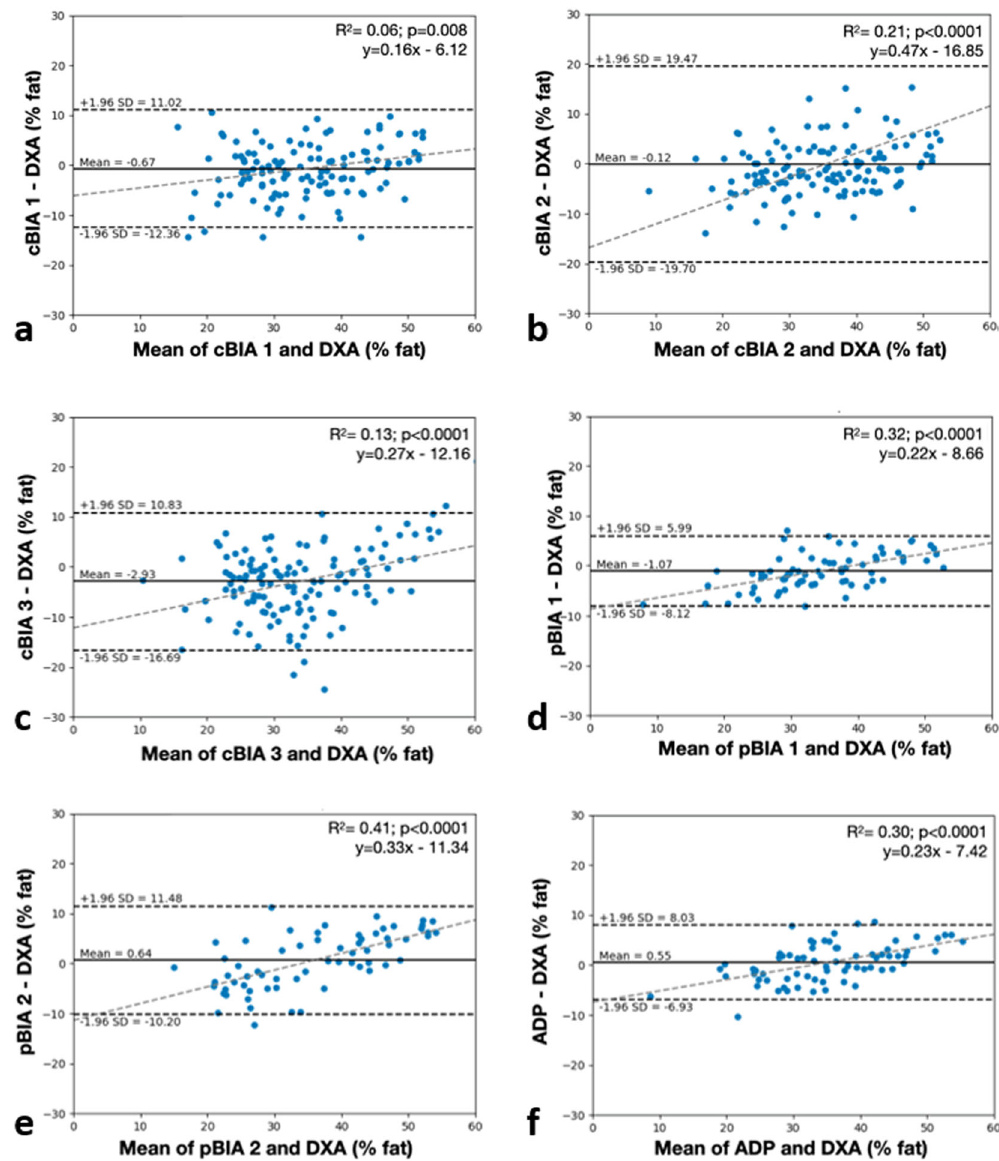
Fig. 4 Bland-Altman analyses of the differences between %BF by DXA and the six methods evaluated for estimation of %BF. a cBIA 1; b cBIA 2; c cBIA 3; d pBIA 1; e pBIA 2; f ADP. The horizontal black lines are at the mean ± 1.96 SD and the dashed gray lines are the fi tted regression